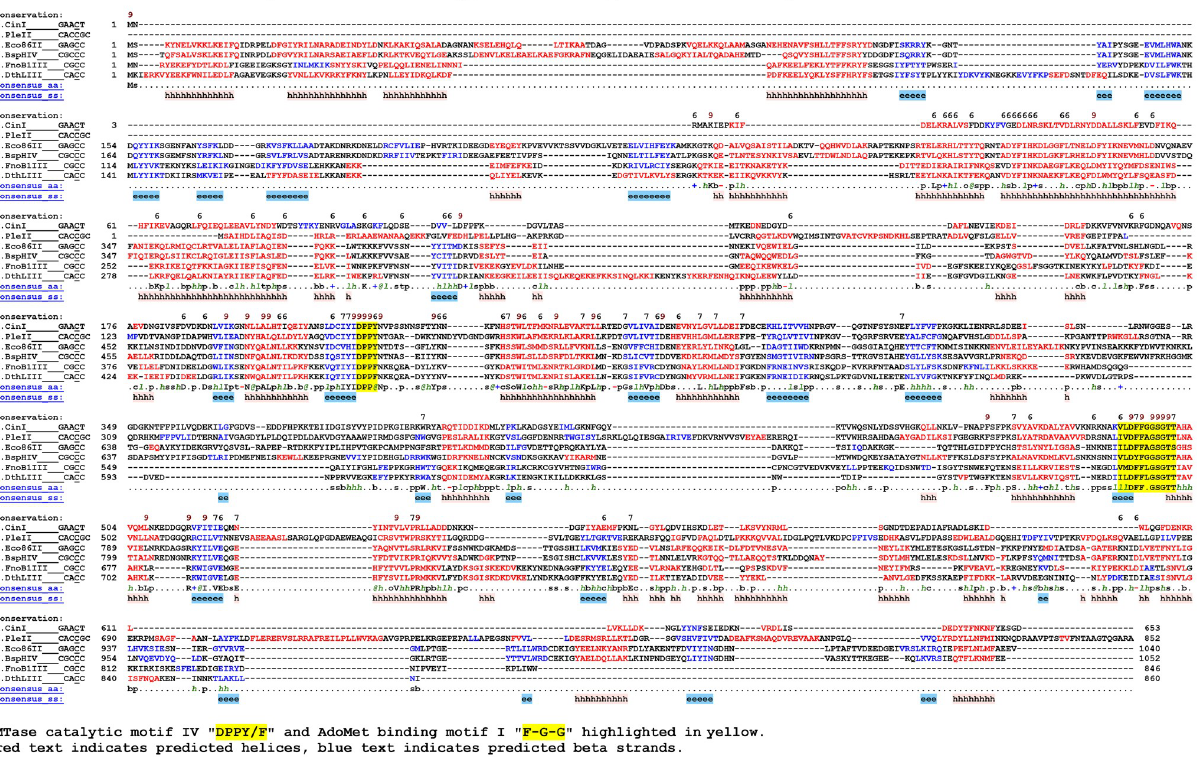
Fig 2. Alignment of the six characterized Type III Methyltransferases that methylate the N4 atom of cytosine. Each of the six Mod proteins are beta- class methyltransferases and contain conserved sequence motifs corresponding to the methyltransferase catalytic motif IV (DPPY) and the AdoMet binding motif I (FGG) described by Malone et al .,